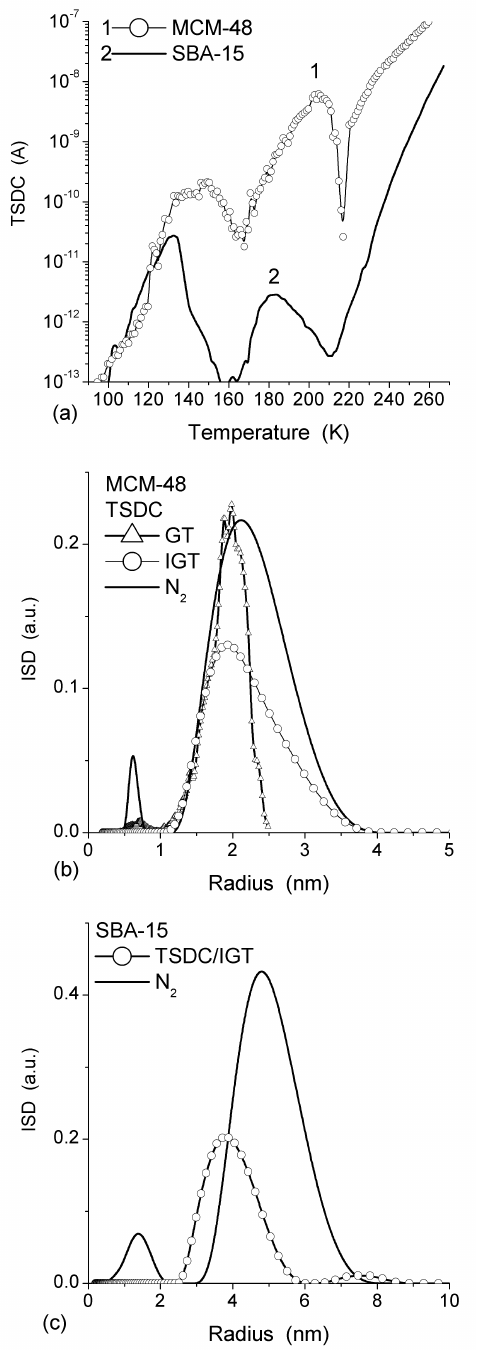
Fig. 9 TSDC thermograms for aqueous suspensions ( h = 5 ml/g) of silicas ( F p = 200- 300 kV/m); and incremental pore size distributions calculated on the basis of nitrogen desorption isotherms for dry powders and the size distributions of water clusters relaxing on the TSDC measurements of aqueous suspensions ( h = 5 ml/g) for (b) MCM-48 (using modified GT and IGT equations), and (c) SBA-15 (modified